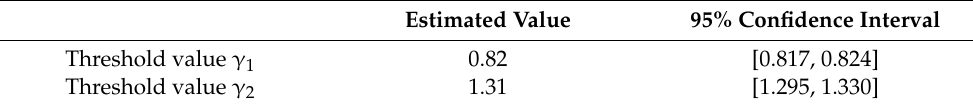
Table 5. Threshold estimation